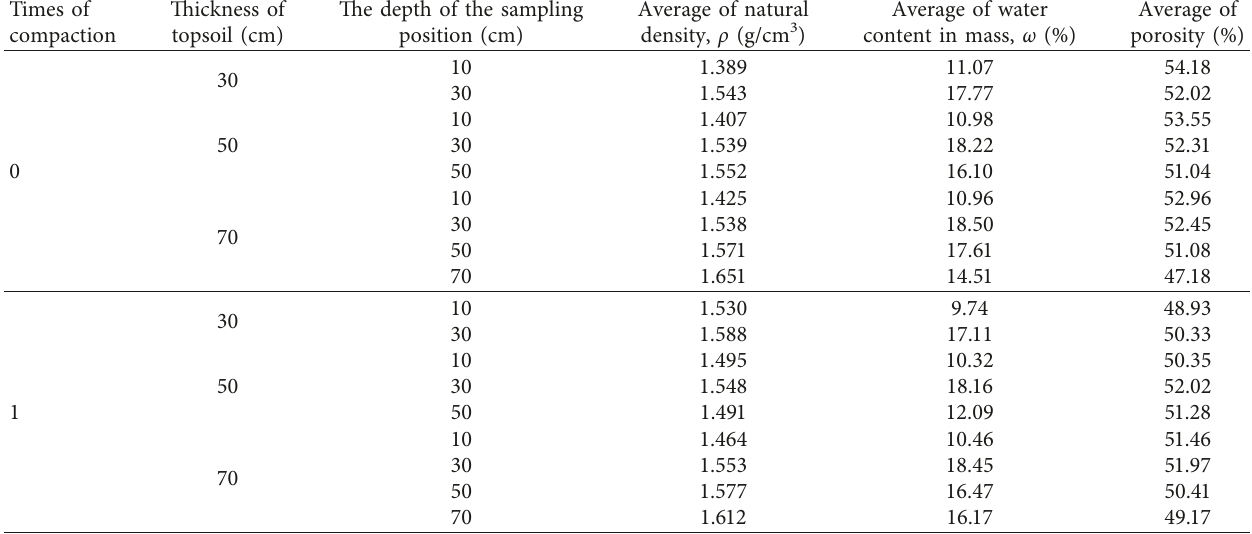
Table 2: Experimental results of the reclaimed soil after a one-year maintenance period.